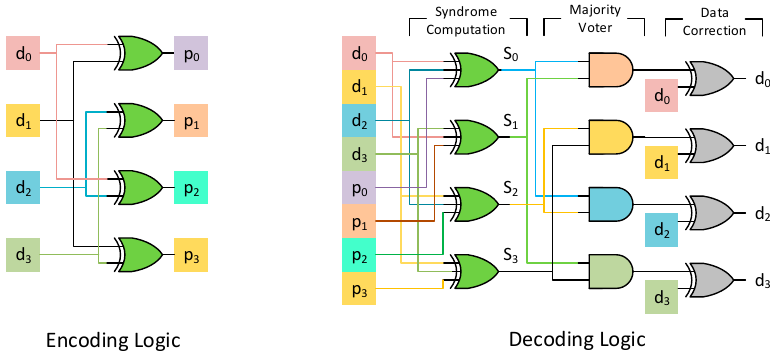
Figure 5. Encoding and decoding circuit of a (8, 4) orthogonal Latin square code.